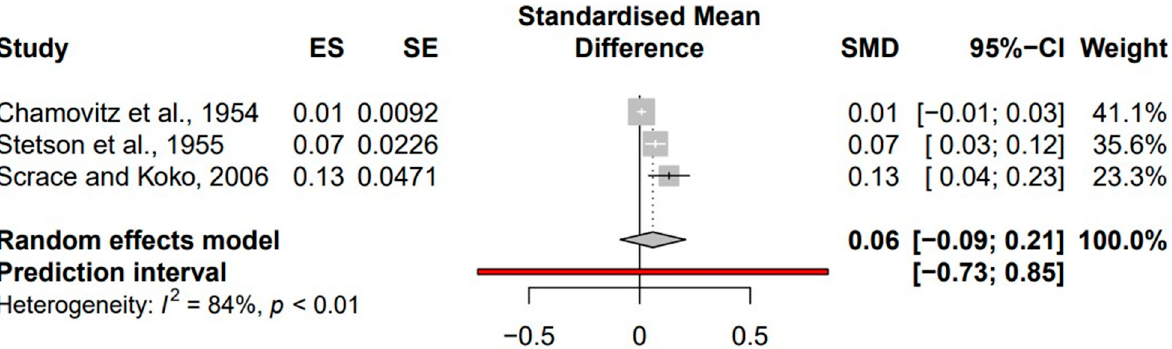
Figure 3. Lists the author and study year, effect size (ES), standard error (SE), standardized mean difference (SMD), and 95% confidence interval (CI) for each study. The forest plot reveals SMD for each study plotted against a random effects model.